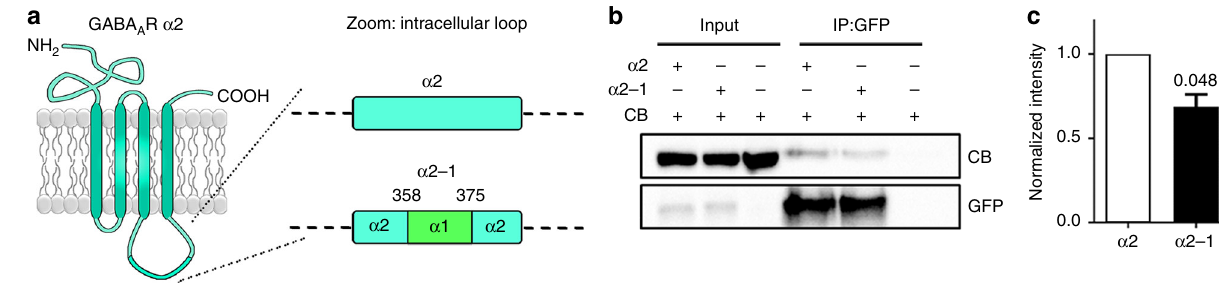
Fig. 2 Substitution of 13 amino acids from the GABA A R- α 1 subunit loop into α 2 reduces collybistin binding. a Cartoon of the GABA A R α 2 subunit, showing the N- and C-termini and the large intracellular loop, expanded to show the site of the α 2 – 1 mutation at amino acids 358 – 375. b Puri fi ed GFP-tagged α 2 or α 2 – 1 was combined with puri fi ed CB and subjected to coimmunoprecipitation. c Quanti fi cation of normalized intensities comparing GFP-tagged α 2 or α 2 – 1 (0.6895 ± 0.08221) interacting with CB. All plots shown and all values listed are mean ± standard error, t test